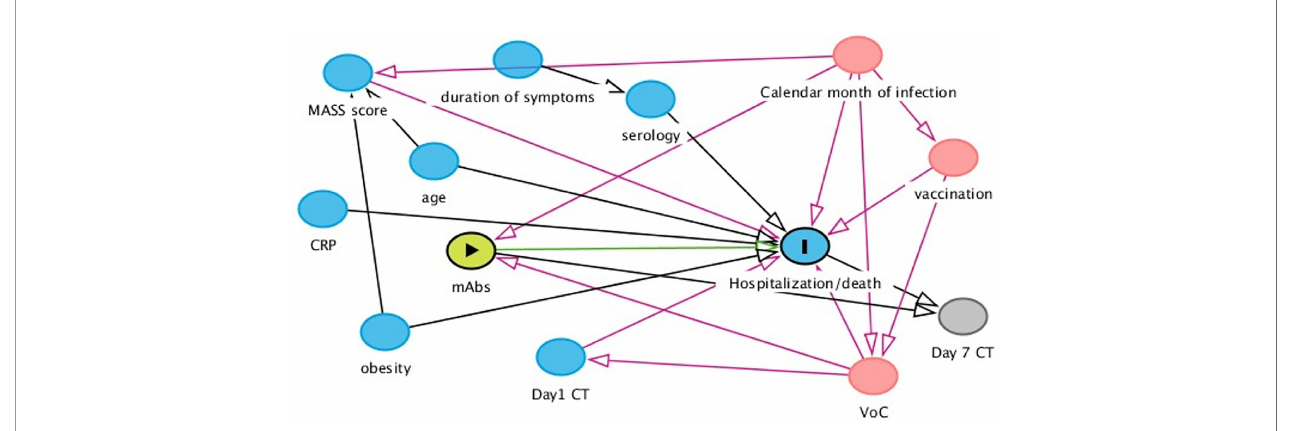
FIGURE 1 | Assumptions regarding the underlying causal link between measured factors. According to our assumptions, month of infusion and type of VoC were identi fi ed as main time- fi xed confounders of our comparison of interest. MASS score was an important predictor and used in some of the models to increase ef fi ciency. Serology test was performed in all participants on the day of the infusion. As a consequence, the result of the test was not known to the prescriber when the intervention was initiated. Consequently, serology cannot be a confounder for the association of